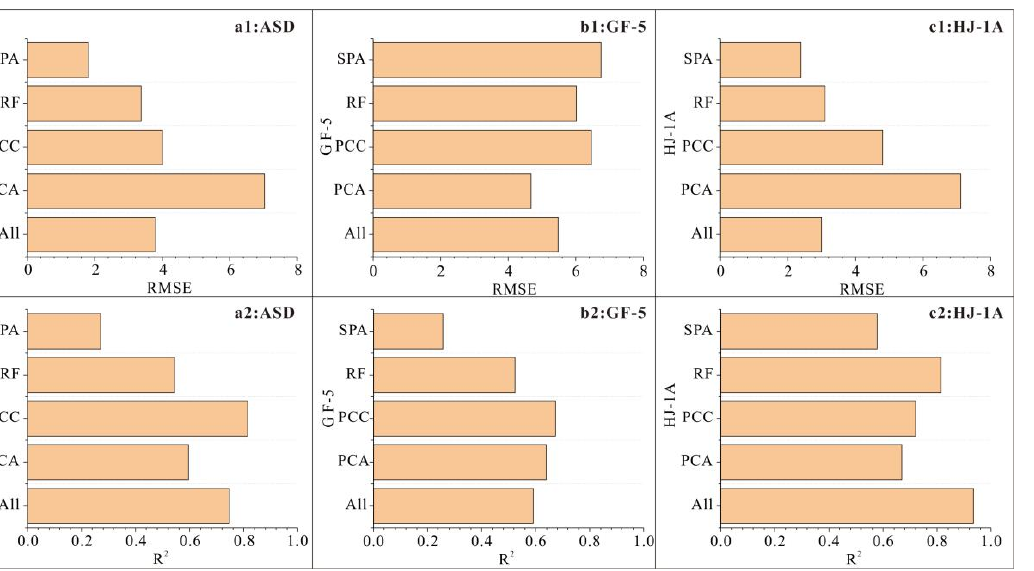
Figure 8. The simulation results of four band screening methods (SPA, RF, PCA, and PCC) for the validation dataset of ASD (( a1 ) RMSE, ( a2 ) R 2 ), GF-5 (( b1 ) RMSE, ( b2 ) R 2 ), and HJ-1A (( c1 ) RMSE, ( c2 ) R 2 ) spectra. ‘ALL’ in this figure represents all bands.